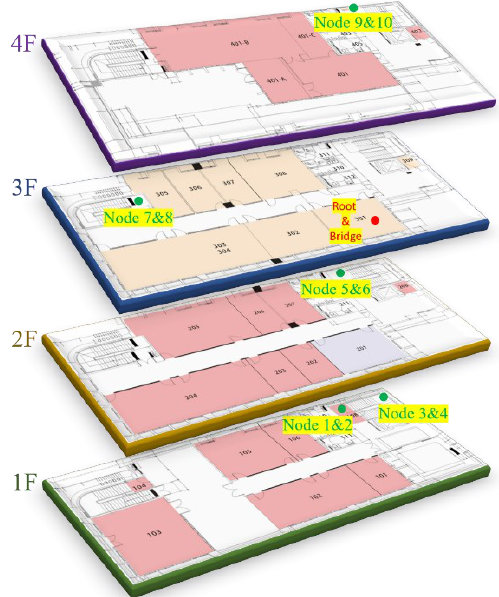
Figure 10. Configuration diagram of the nodes’ positions.